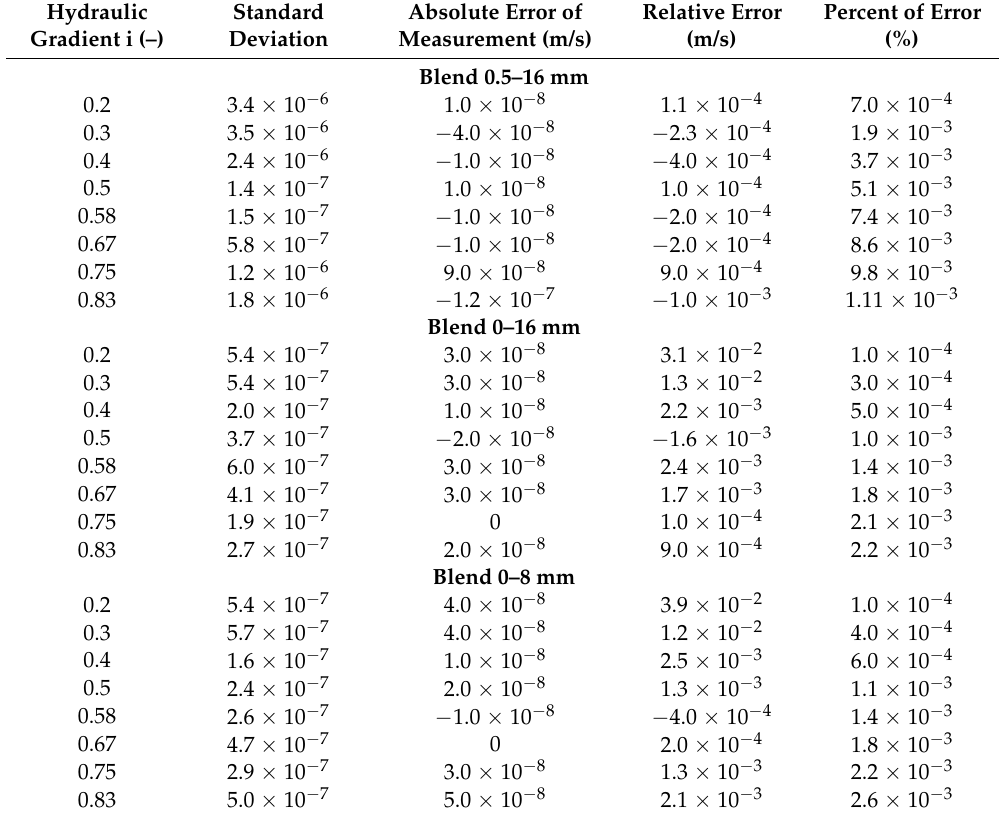
Table 2. Estimated errors of the flux velocity measurements for each of the gradients and blends.